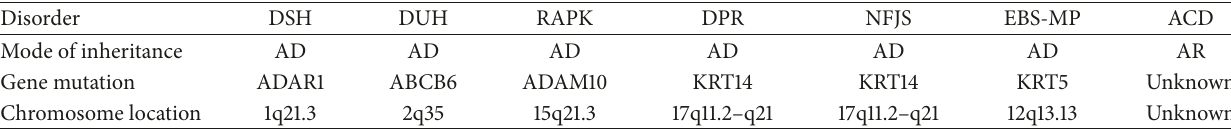
Table 2: Summary of genetic differences between hereditary reticulate pigmentary disorders.